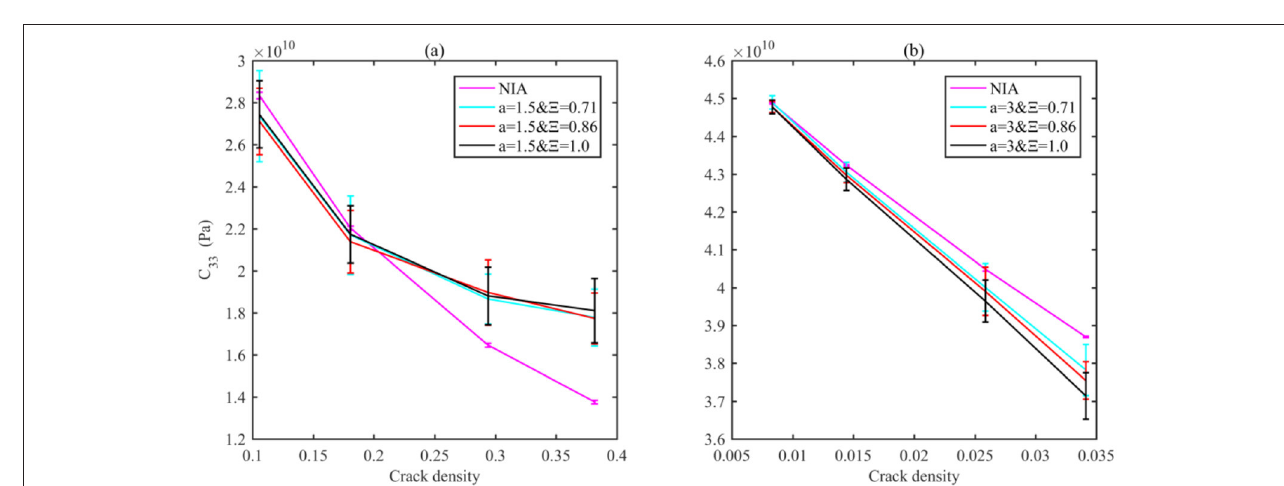
FIGURE 6 | C 33 as the functions of fracture densities for different models determined by a and 4 , using the NIA solution and the numerical method. The lengths of bars are the standard deviations for 20 different realizations by changing the crack locations with the same crack density.